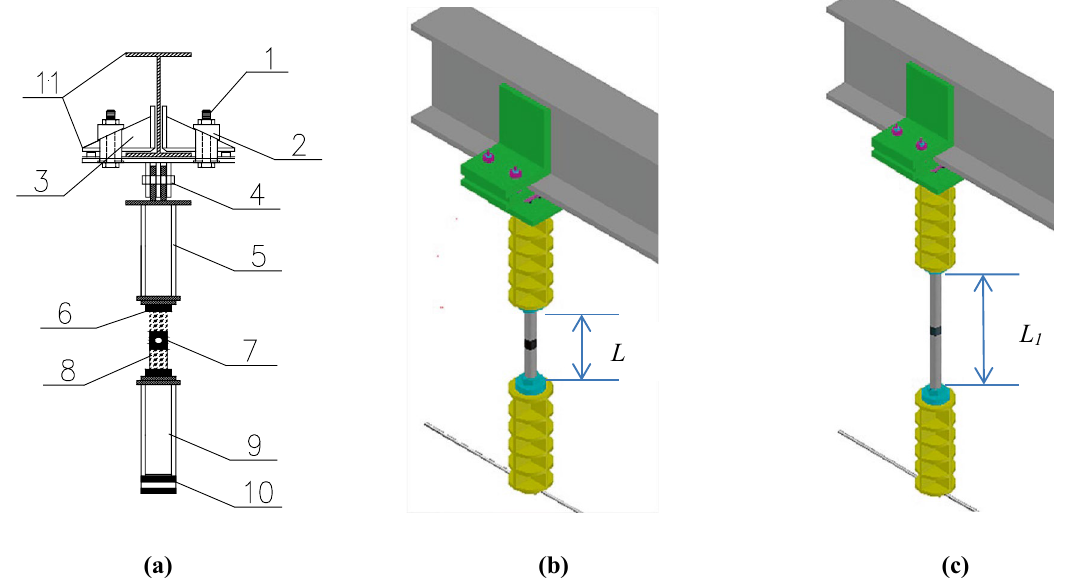
nection hole, 11. Steel beam; b 3D model of strut before loading; c 3D model of strut after